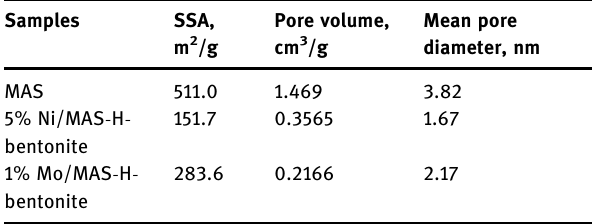
Table 1: Physical properties of MAS, Ni/MAS - bentonite, and